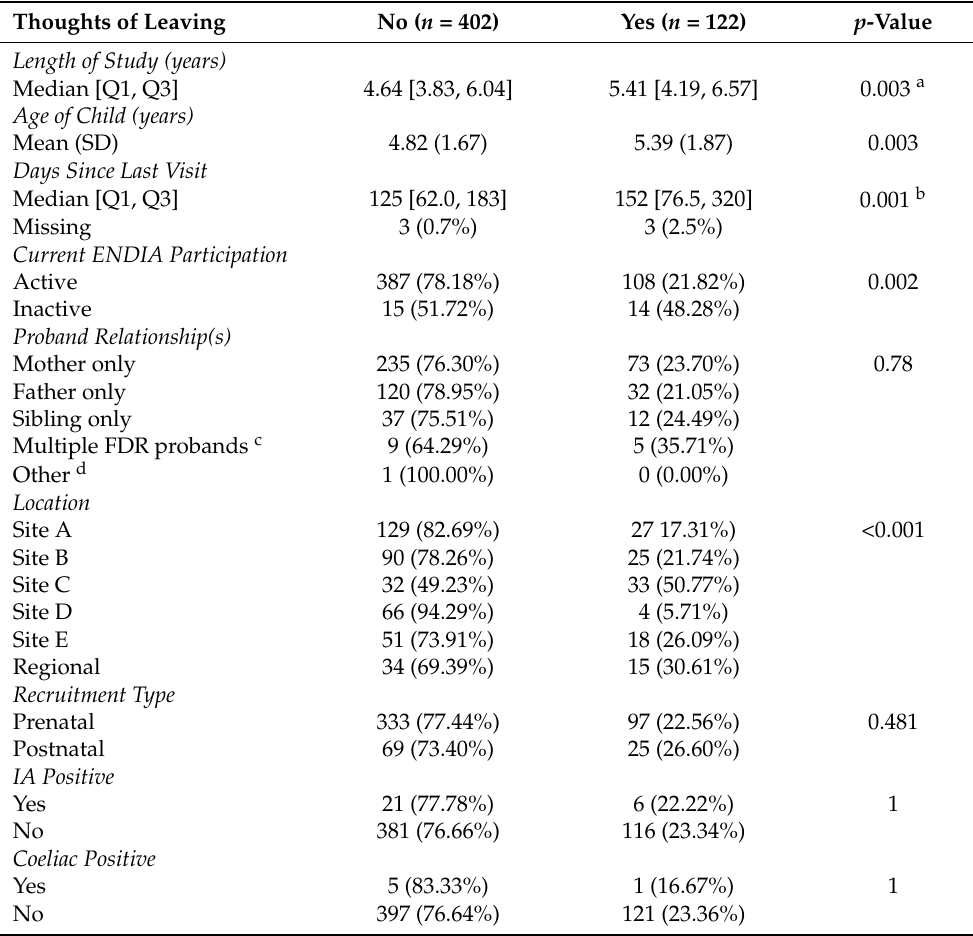
Table 2. Demographics of caregivers with thoughts of leaving ENDIA based on 524/550 responses to the